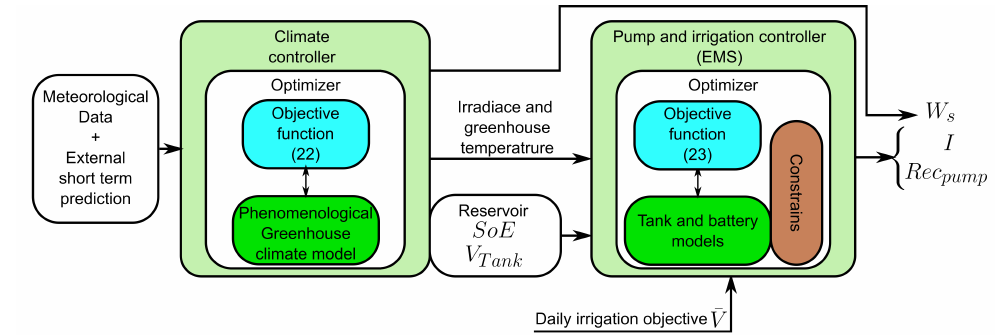
Figure 2. Short-term management optimization flow chart, where PSO is used for both optimizations.